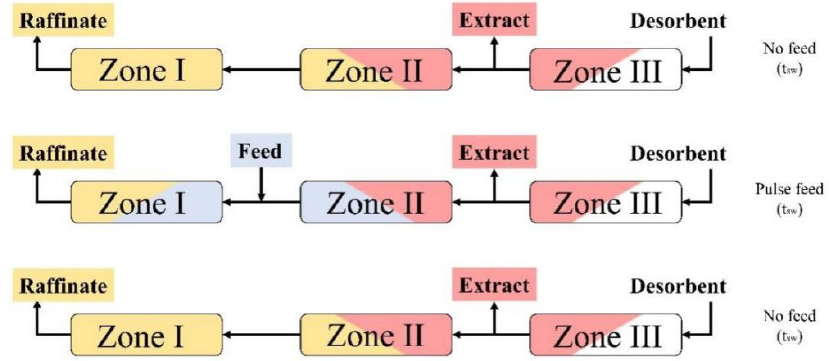
Figure 9. Schematic diagram of the three-zone SMB (“partial feed” operation).